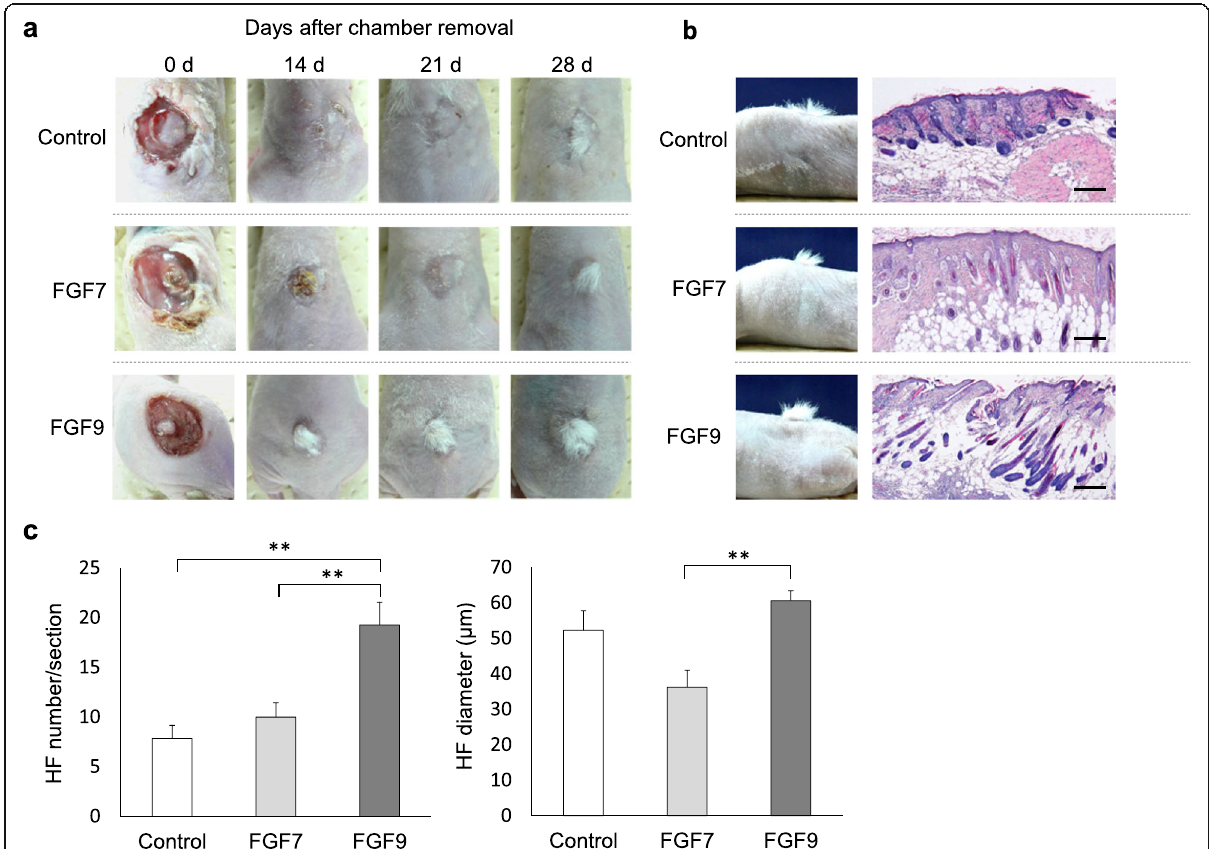
Fig. 4 Effects of FGF7/9 on hair induction in vivo hair reconstitution assay. a Representative time course of re-epithelization and hair regeneration after the removal of chamber in control and FGF7- and FGF9-treated groups were presented. b Representative histopathology of re-epithelized skin 6 weeks after the removal of chambers in three groups. Terminal hairs were remarkable in the FGF9-treated group, whereas hair follicles observed in the control and the FGF7-treated groups were comparatively immature. Scale bars = 10 μ m. c Regenerated hair follicle (HF) density (total HF number per one vertical section) and the average HF diameter in three groups. FGF9 group presented increase in both the number and the diameter of newly formed HFs. * p < 0.05. ** p < 0.01. The data were obtained from seven respective